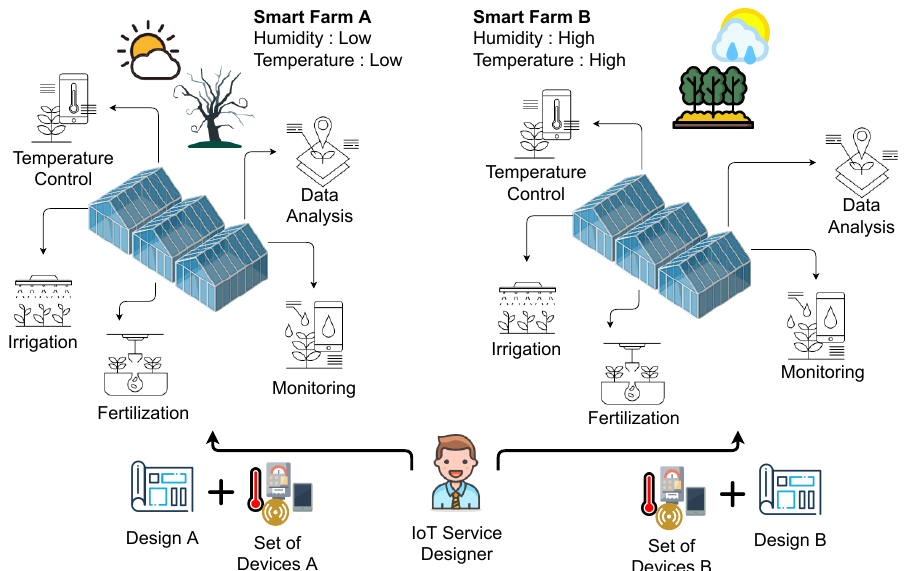
Figure 1. Example of the problem of IoT service implementation in a different environment. Two different environments but with the same IoT service, i.e., a smart farm, require specific devices for each environment due to different capabilities and availability. Therefore, the designer will have to repeat the design process and implementation process for each